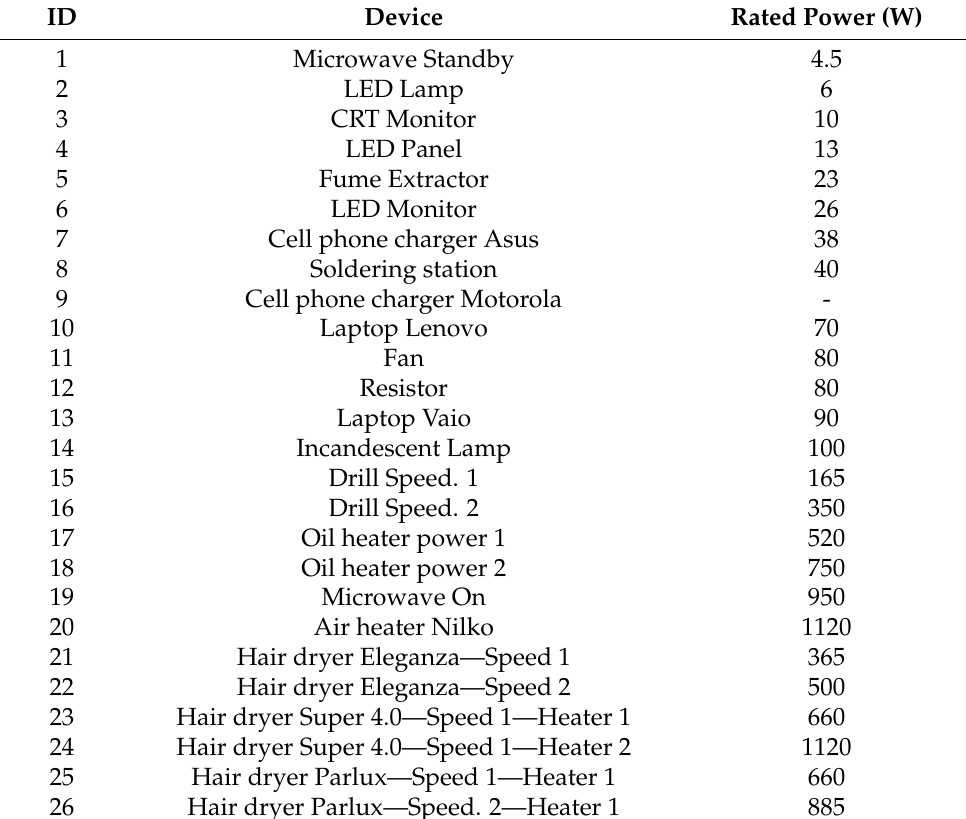
Table 1. Appliances in LIT Synthetic Subset (LIT-SYN).